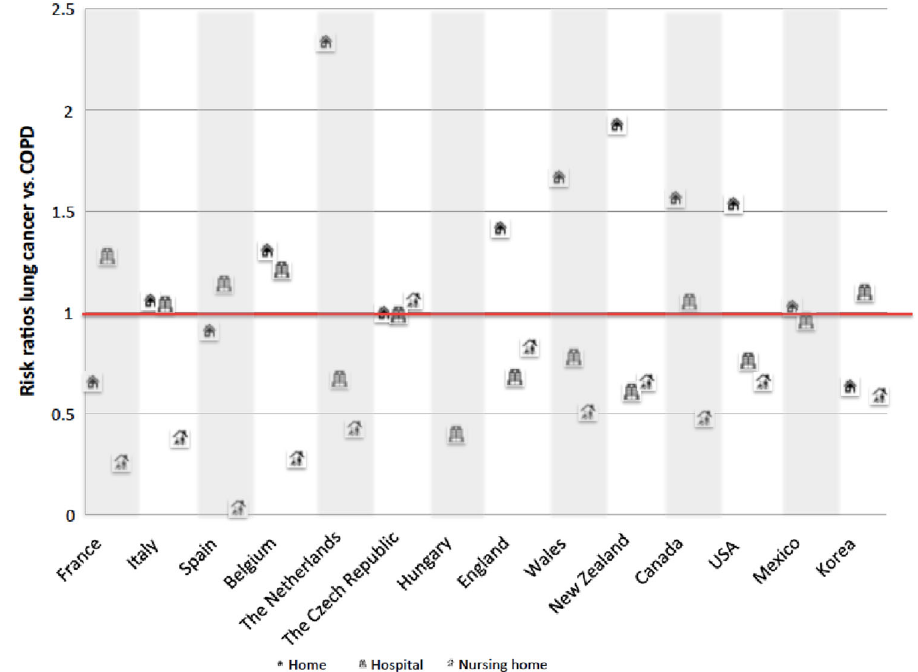
Fig. 1 Crude risk ratios for dying at home, in hospital, in a nursing home, in a palliative care institution of those dying from lung cancer vs. those from COPD. Risk ratios calculated as proportion lung cancer/proportion COPD dying in each place. A risk ratio > 1 indicates that those with lung cancer were relatively more likely to die in that place compared to those with COPD deaths; a risk ratio < 1 means that they were less